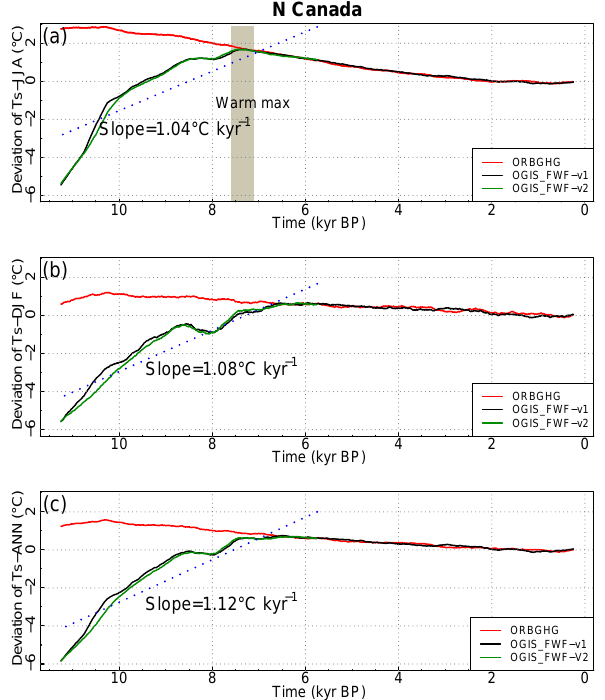
Figure 6. Same as Fig. 4 but for northern Canada (120–55 ◦ W, 50– 69 ◦ N).